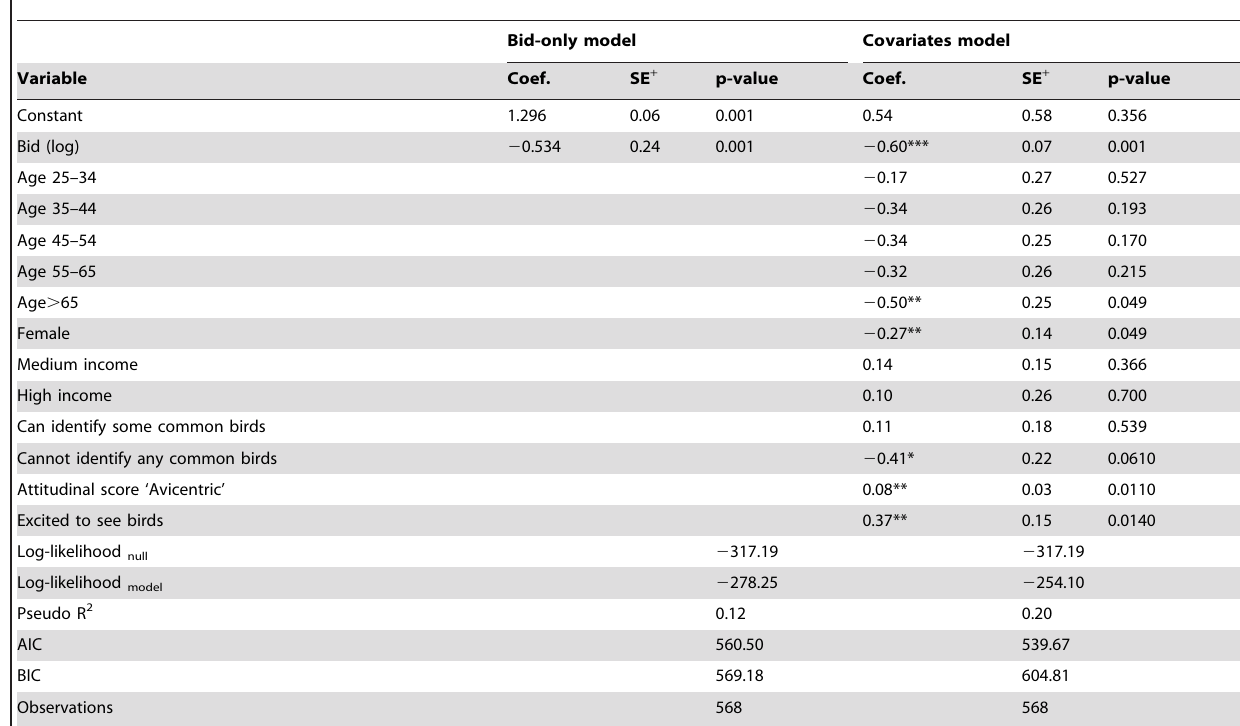
Table 6. Bid-only and covariates model (probit), depended variable =Yes/No response to offered bid.